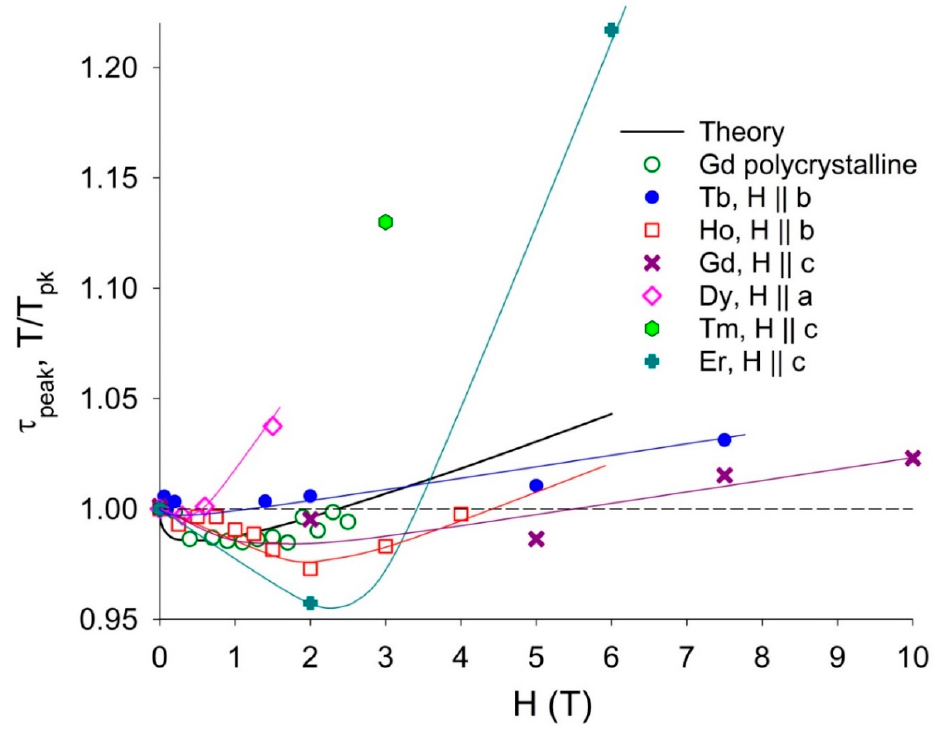
Figure 9. Position of the maximum in the magnetic specific heat of heavy REM in dependence on the magnetic field. The experimental data for Gd is taken from [72,153], Tb [71], Dy [46,73], Ho [62], Er [154], Tm [155]. Lines drawn through the data points are guides for the eye. The theoretical curve (solid black line) is from [152].